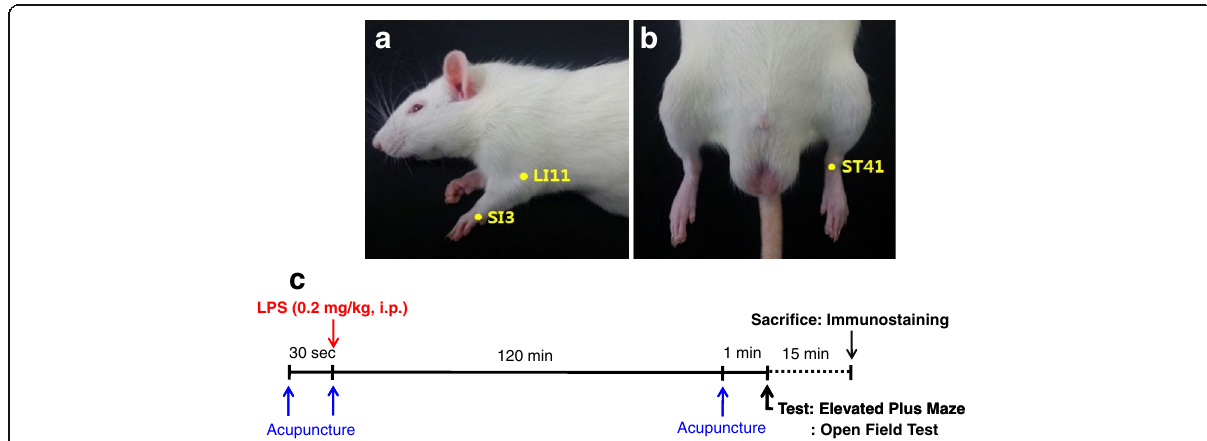
Fig. 1 Acupuncture treatment and experimental procedure. a, b Location of SI3, LI11, and ST41 acupoints. c Experimental protocol. Rats were given three times acupuncture stimulation at SI3, LI11, and ST41 acupoint for 30 s before and 2 h after administration of lipopolysaccharide (LPS, 0.2 mg/kg,